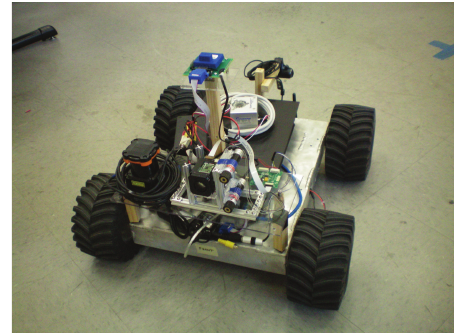
Figure 20. Test platform used for indoor tests.